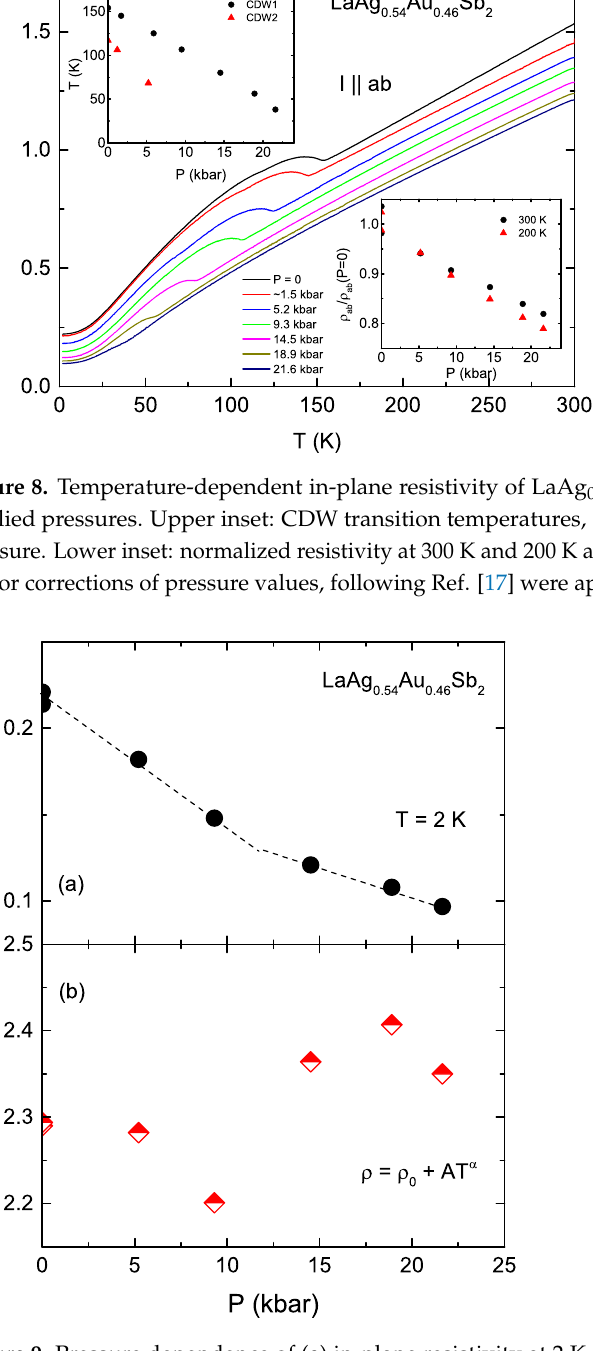
Figure 9. Pressure dependence of ( a ) in-plane resistivity at 2 K (dashed lines are guide to the eye); ( b ) exponent α in ρ = ρ 0 + AT α fit of low temperature resistivity (fit performed between 1.8 K and 20 K) for LaAg 0.54 Au 0.46 Sb 2